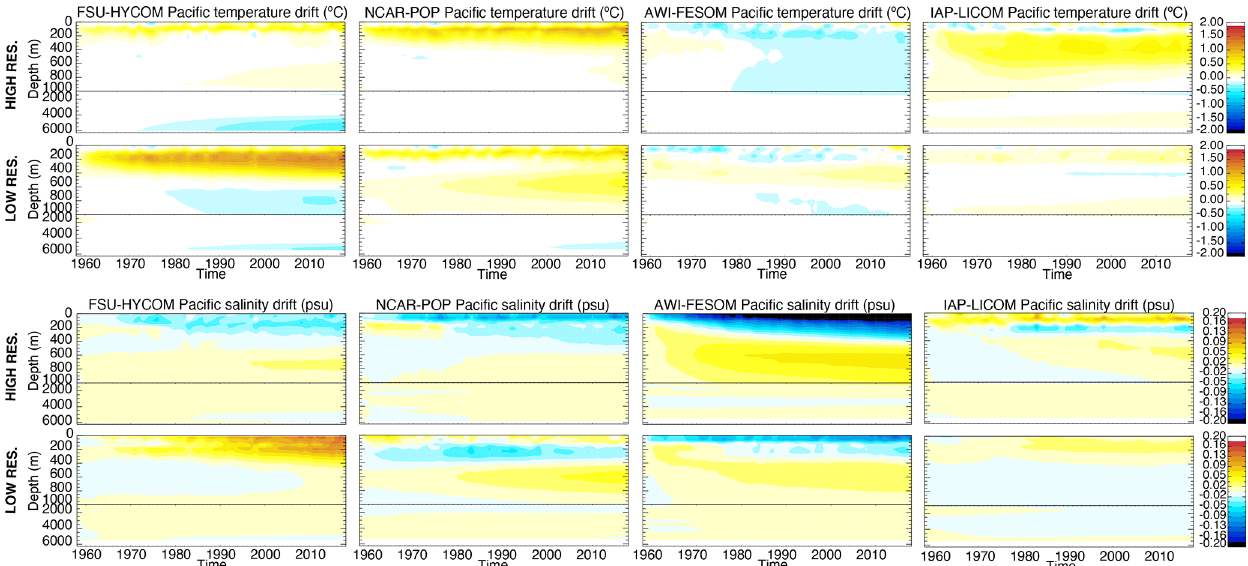
Figure 8. Time evolution of Pacific Ocean temperature ( ◦ C) and salinity (psu) change (relative to initial conditions) as a function of depth for all experiments.